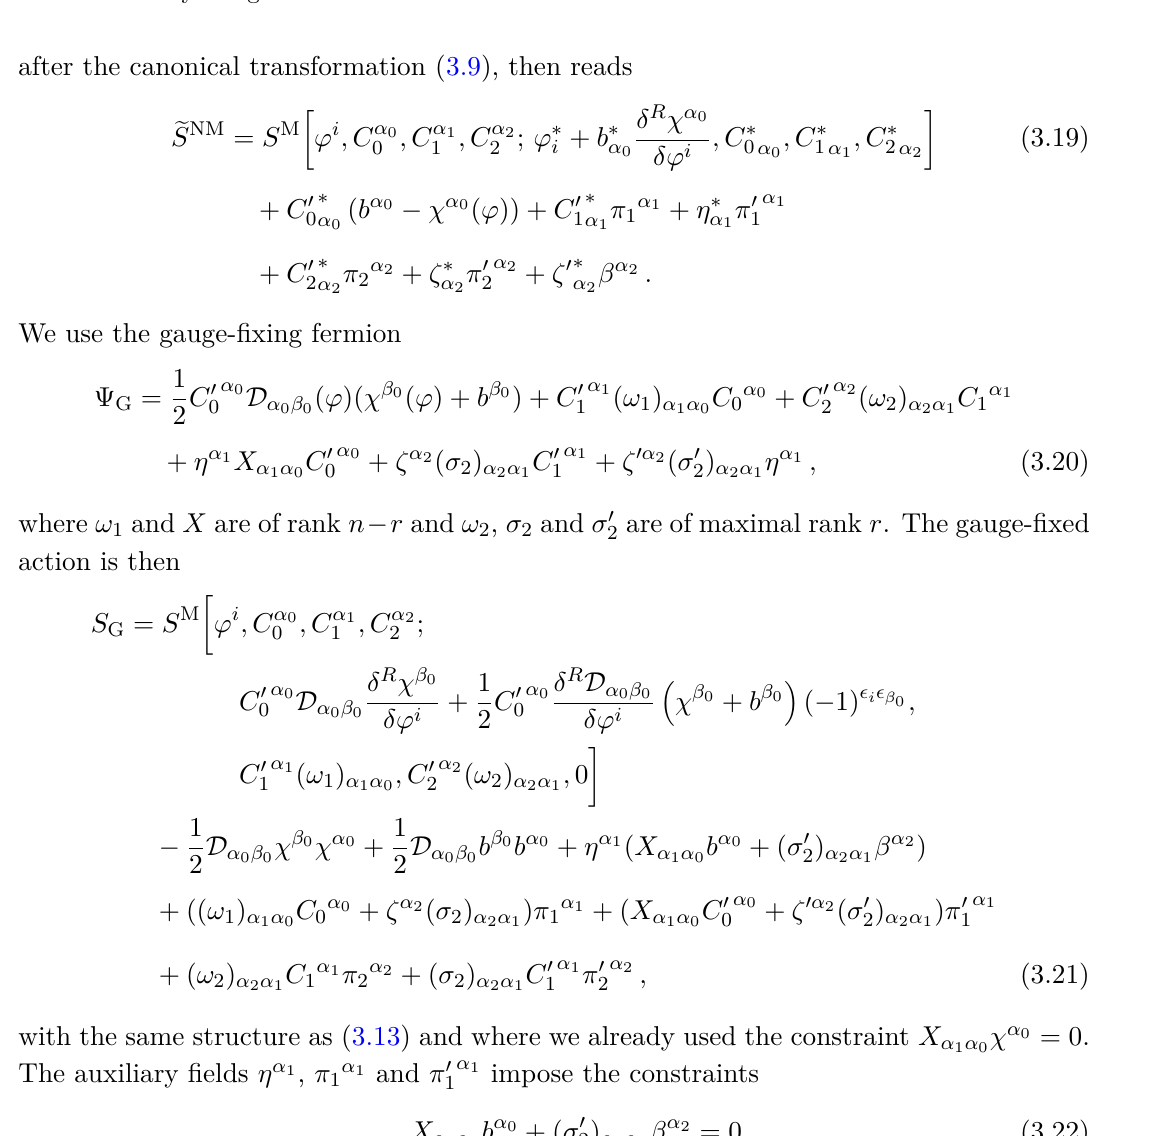
Figure 2 . The pyramids of ghost fields in the second-stage reducible case [4]. This should be read in the same way as figure